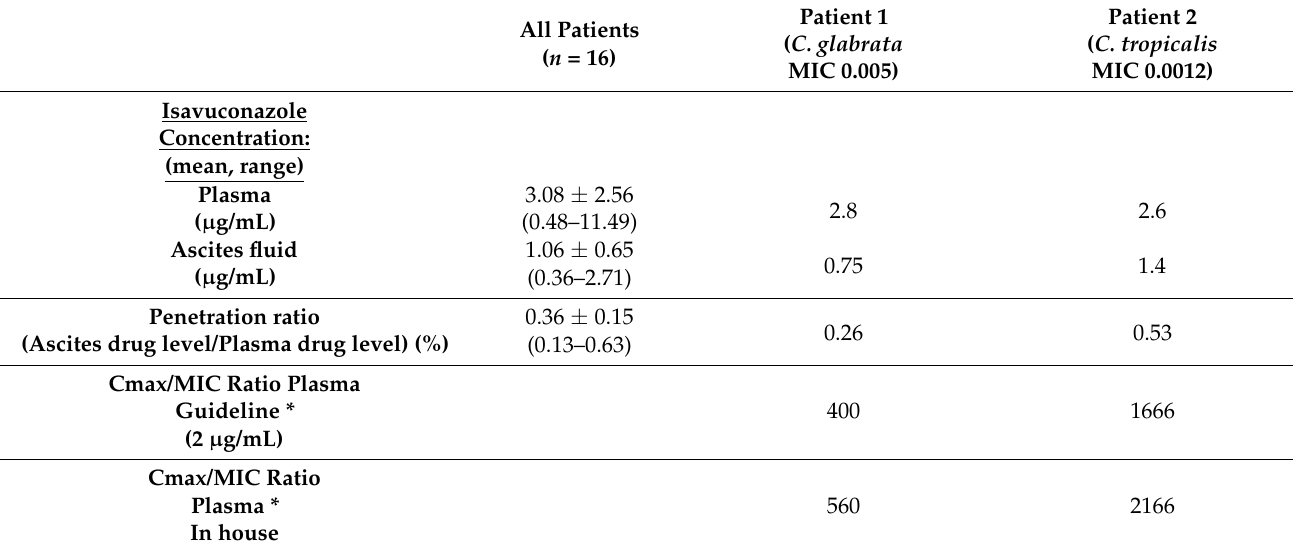
Table 2. Isavuconazole concentrations in plasma and ascites fluid, penetration rates and Cmax/MIC